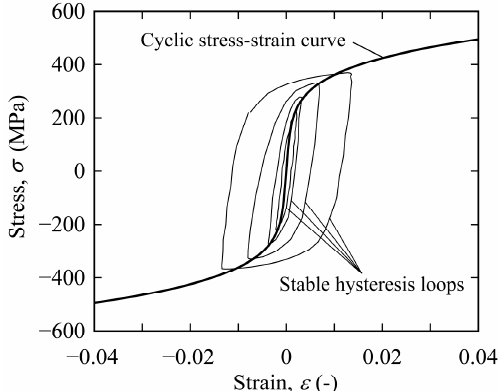
Figure 3. Cyclic stress − strain curve of the steel.